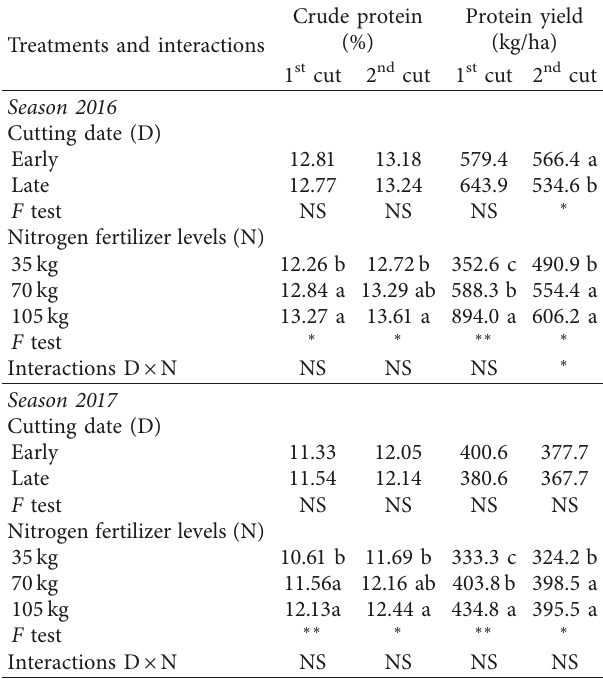
Figure 4: Dry forage yield of Sudan grass as affected by the interaction between cutting date and nitrogen fertilizer levels at the 1 st and 3 rd cuts in the first season and the 2 nd cut in the second season. The bars on the top of column represent the SE for each cut. Table 4: Crude protein content (%) and protein yield (kg/ha) of Sudan grass as affected by cutting date and nitrogen fertilizer levels during 2016 and 2017 summer